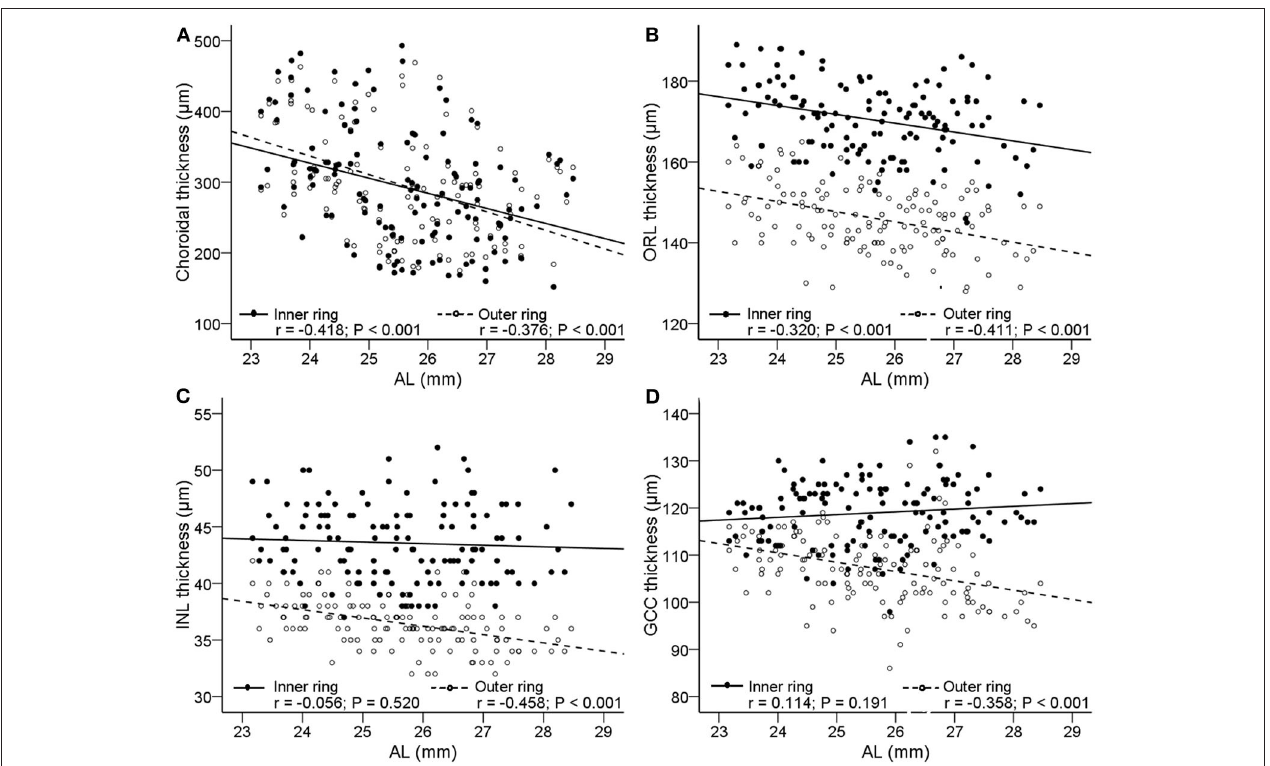
FIGURE 4 | Correlations between AL and the thickness of choroid and retina. Scatterplots showing AL vs. (A) choroidal thickness; (B) outer retinal layer (ORL); (C) inner nuclear layer (INL); (D) ganglion cell complex (GCC). The solid lines and filled circles represent the results in the inner ring. The dashed lines and open circles represent the results in the outer ring. AL, axial length; ORL, outer retinal layer; INL, inner nuclear layer; GCC, ganglion cell